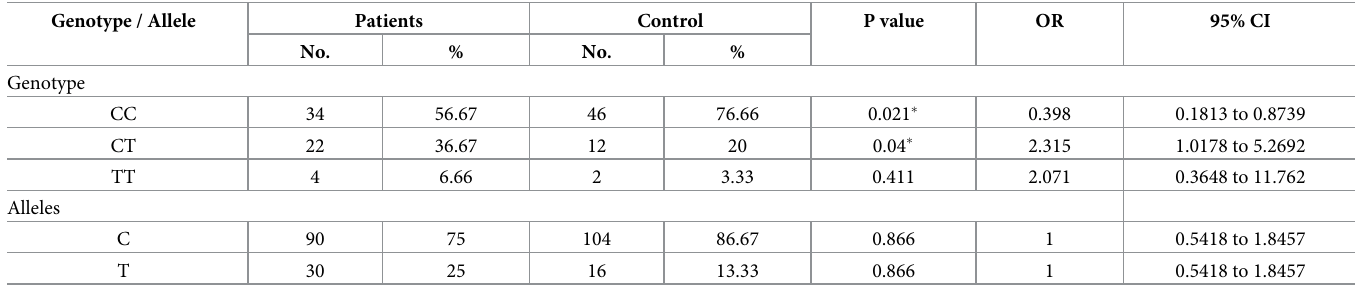
Table 4. Genotype distribution (CC, CT, TT) and alleles (C, T) of rs2268491 in patients with ASD (N = 60) and healthy controls (N = 60). Genotype / Allele